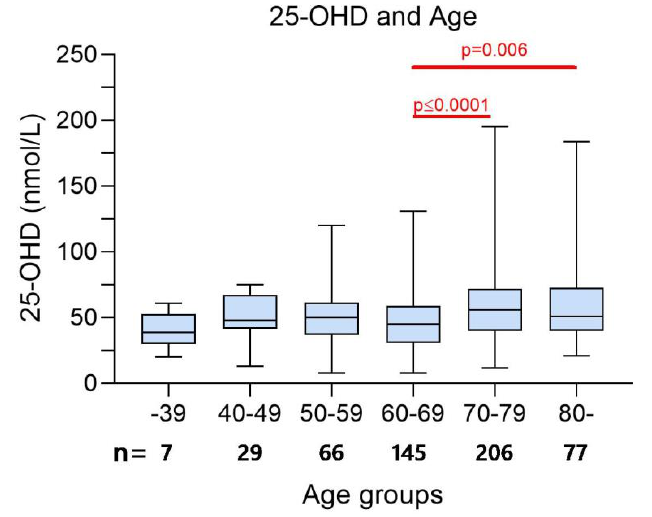
Figure 4. Cross-sectional 25-OHD in relation to age ( n = 530). Median 25-hydroxyvitamin D (25-OHD) values in nmol/L in the screening cohort ( n = 530) of the ‘Palliative-D’ study, included the interquartile range and min-max values. Comparisons between groups was performed with Mann–Whitney U. In the 60–69 years age group, the median 25-OHD was lower than in the 70–79 years age group (45 vs. 56 nmol/L, 95% CI −15 to −5, p < 0.0001, and in the 80+ years age group (45 vs. 51 nmol/L, 95% CI −15 to −2, p = 0.006).